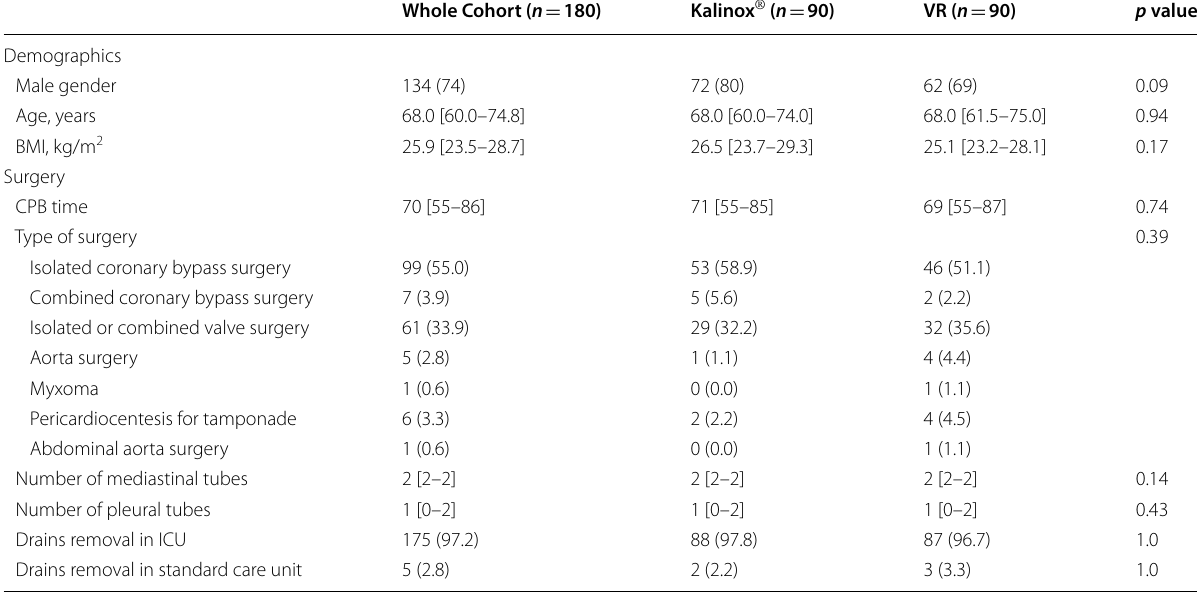
Table 1 Baseline